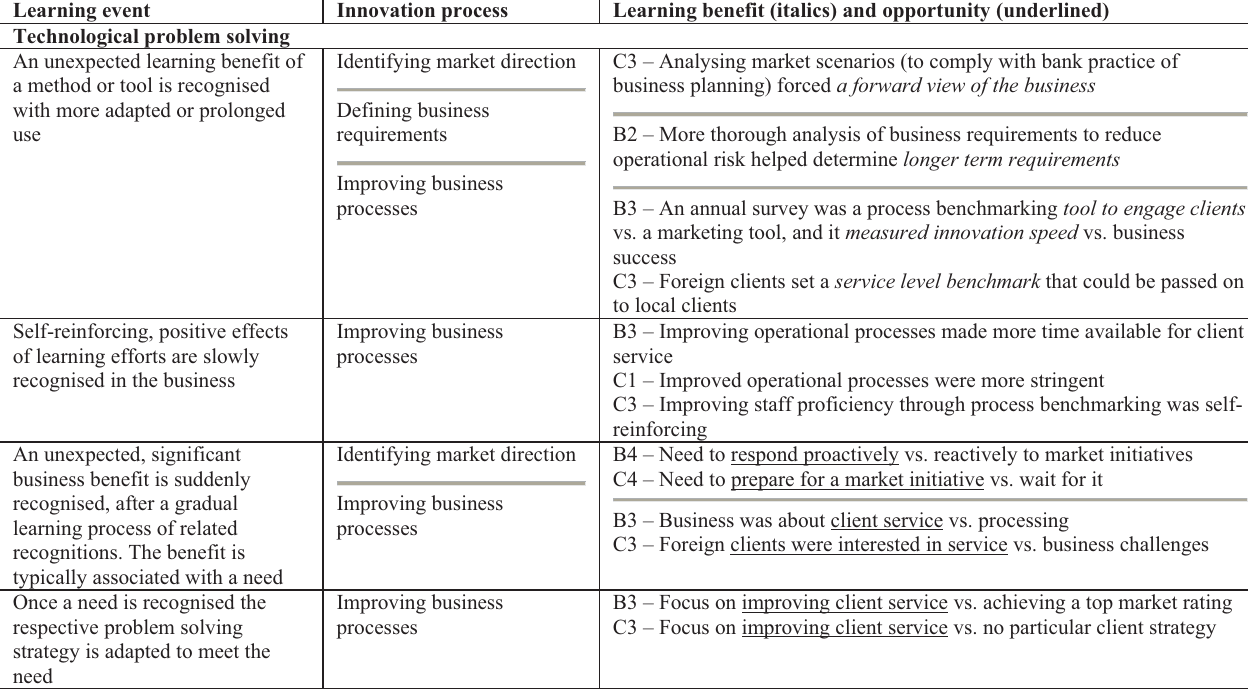
Table 2: Expert learning